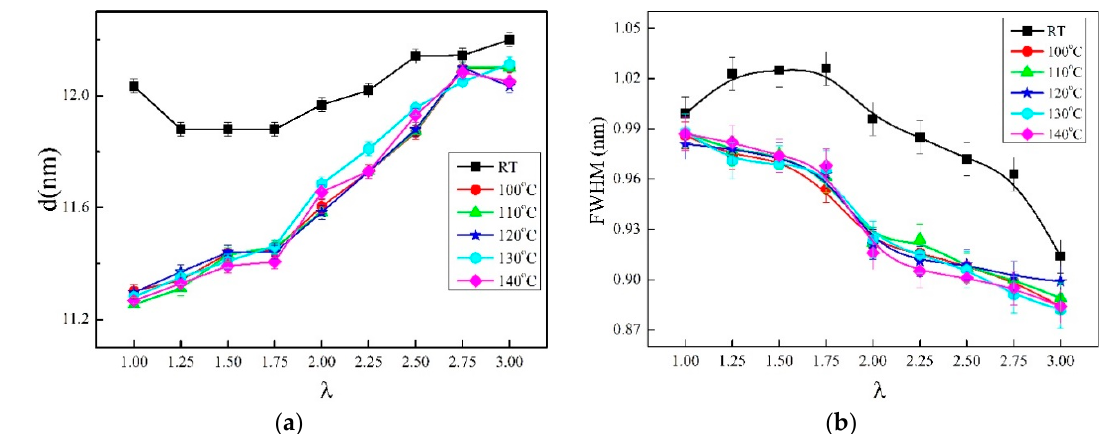
Figure 4. The d -spacing and FWHM of (002) of synchronous thermal stretched γ -PA1010 at different temperature. ( a ): d -spacing; ( b ) FWHM.